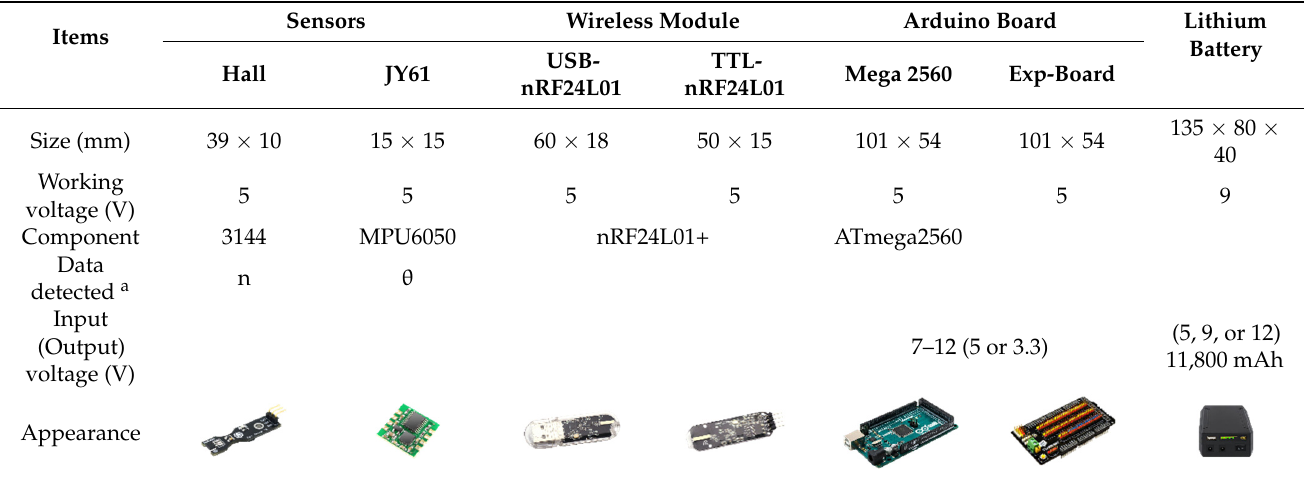
Table 2. The basic parameters and appearance of the hardware.